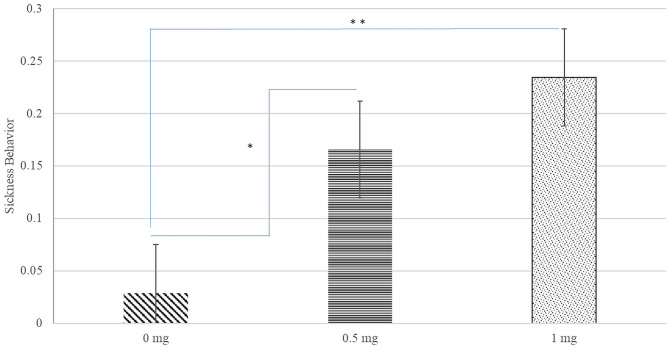
Probability of sickness behavior (estimate and standard error of the mean) by Poly(I:C) dose (0, 0.5, or 1 mg/kg of body weight). **, *Difference between Poly(I:C) doses significant at P-value < 0.005, and P-value < 0.05, respectively (n = 10). Probabilities are unitless and values range from 0 to 1.